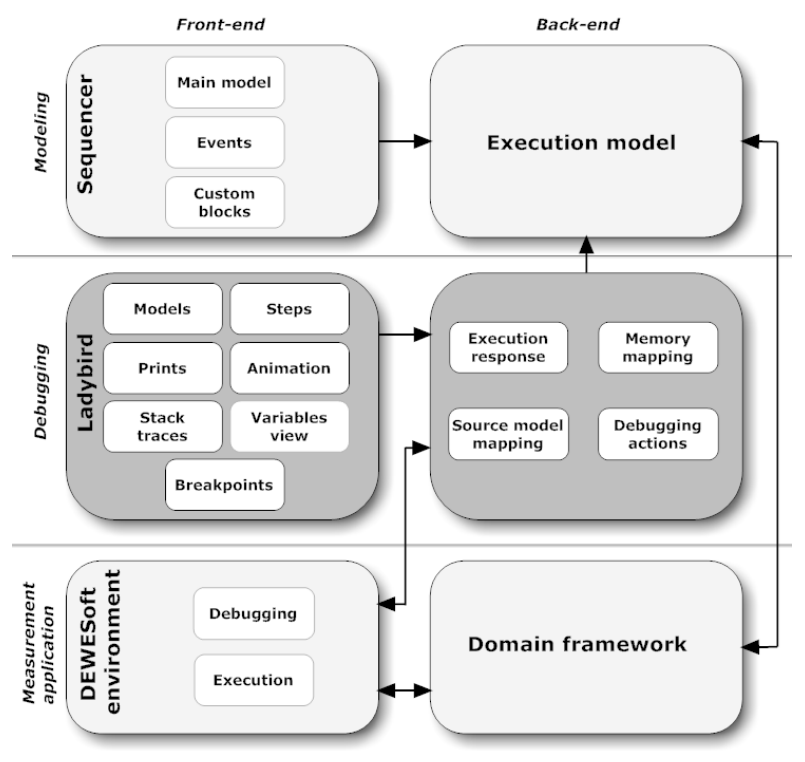
Figure 3. Debugger support in